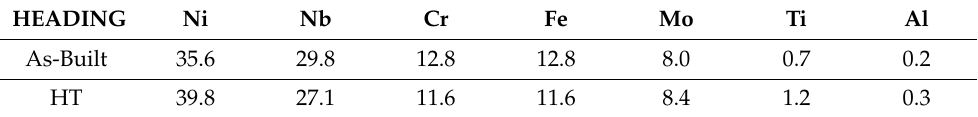
Table 5. Number density and volume fraction of δ phase in HT specimens.